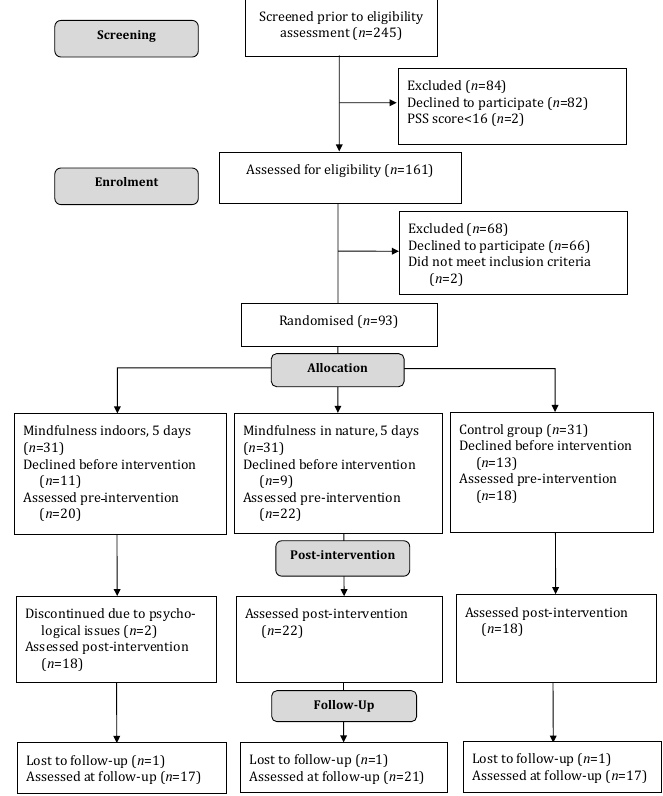
Figure 1. Flow chart, enrolment of students